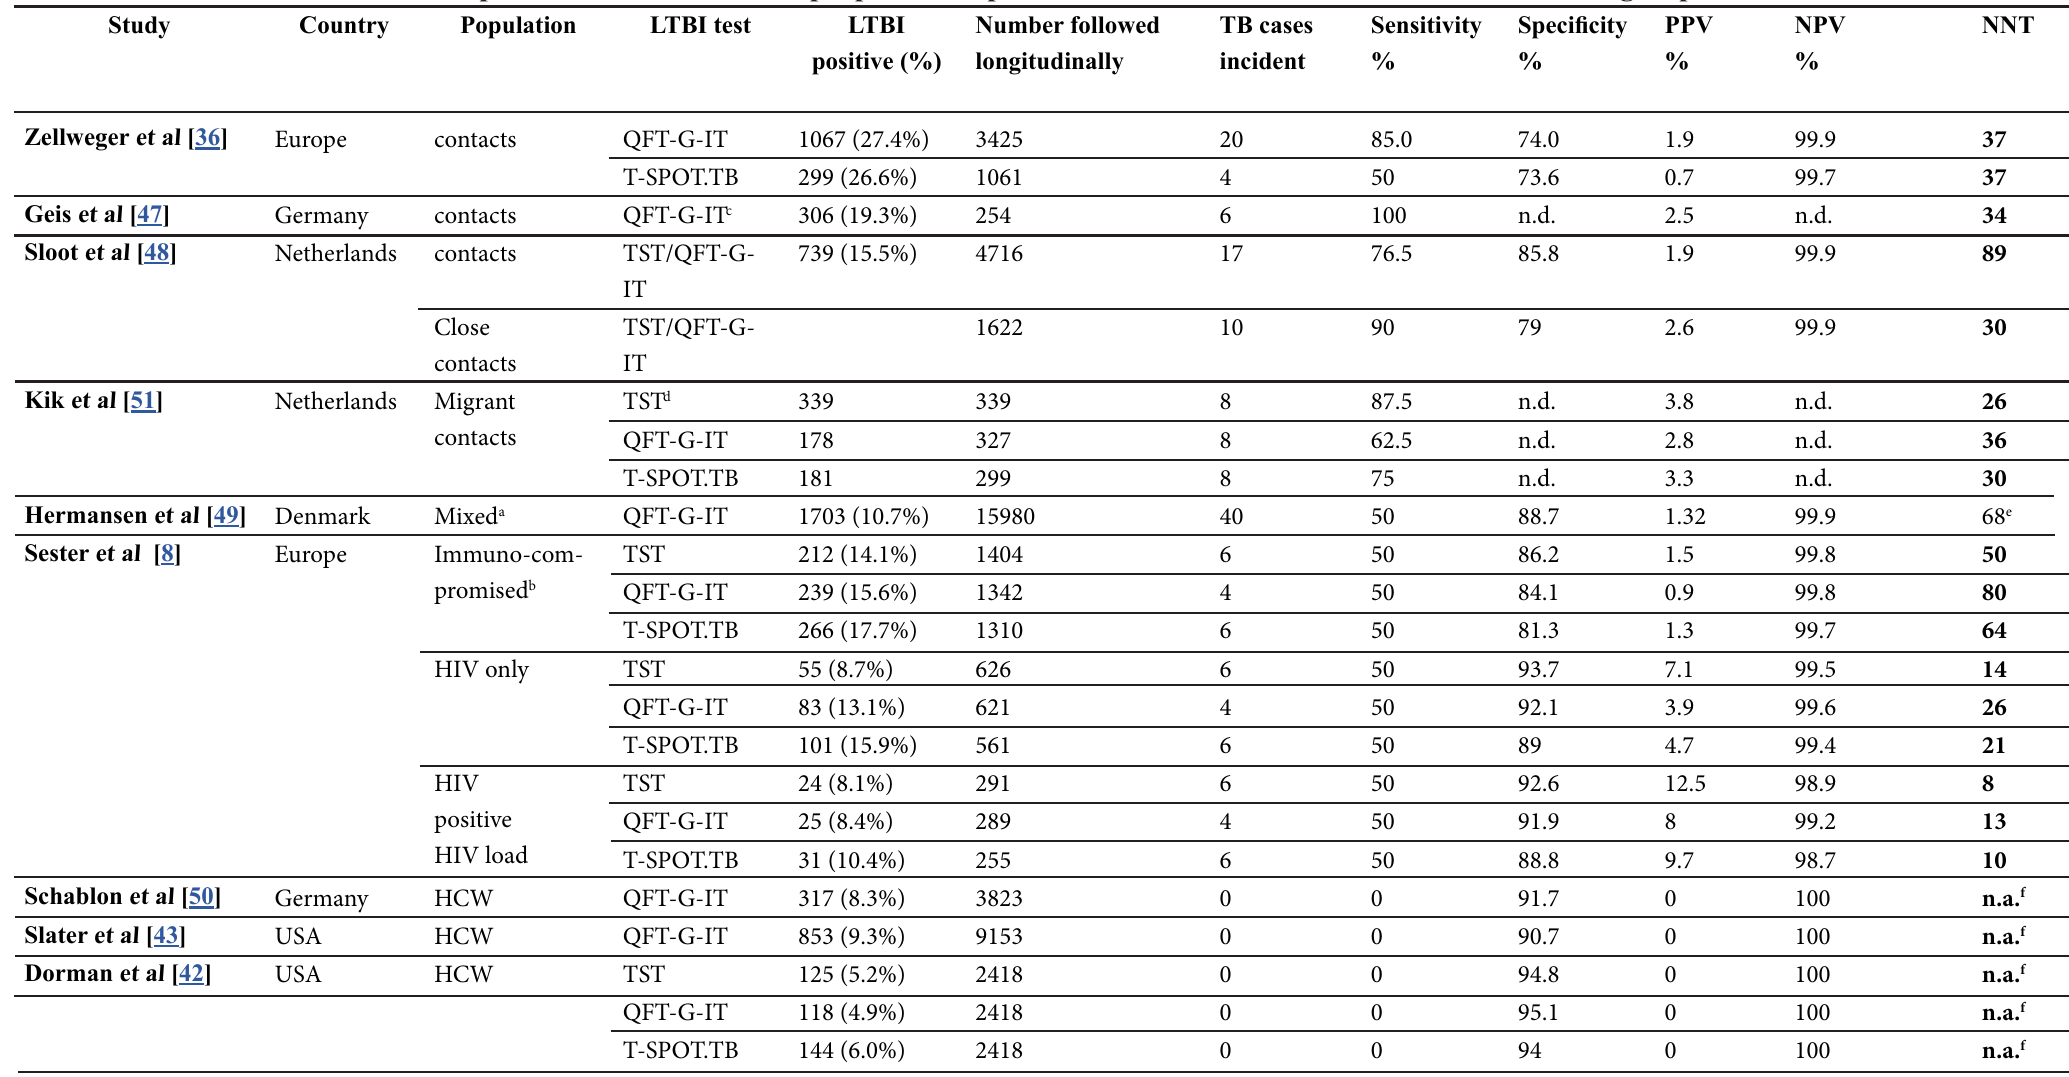
Table 3. Numbers needed to treat to prevent one case of TB in people with a positive IGRA or TST test result in different risk-groups in low incidence countries